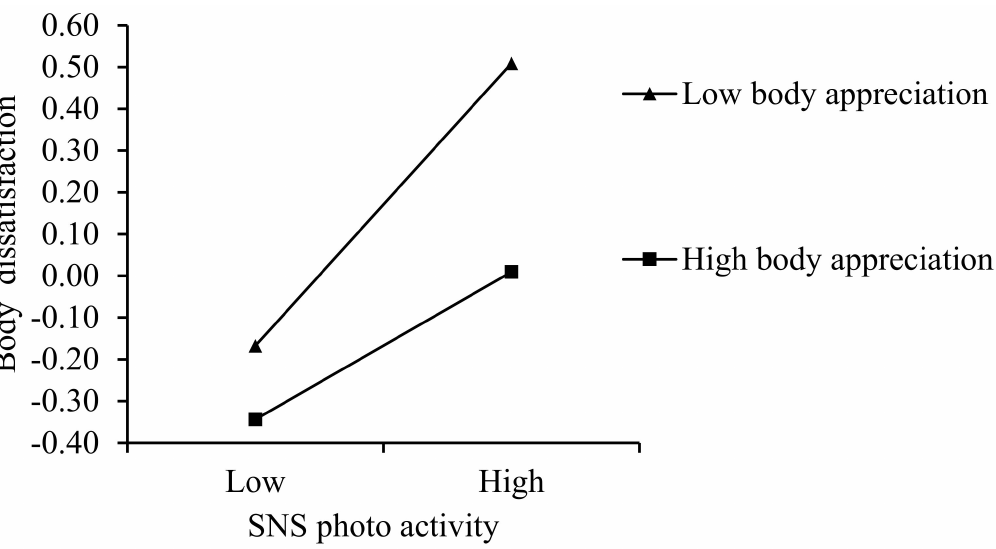
Figure 2. Body appreciation moderated the relationship between SNS photo dissatisfaction and body